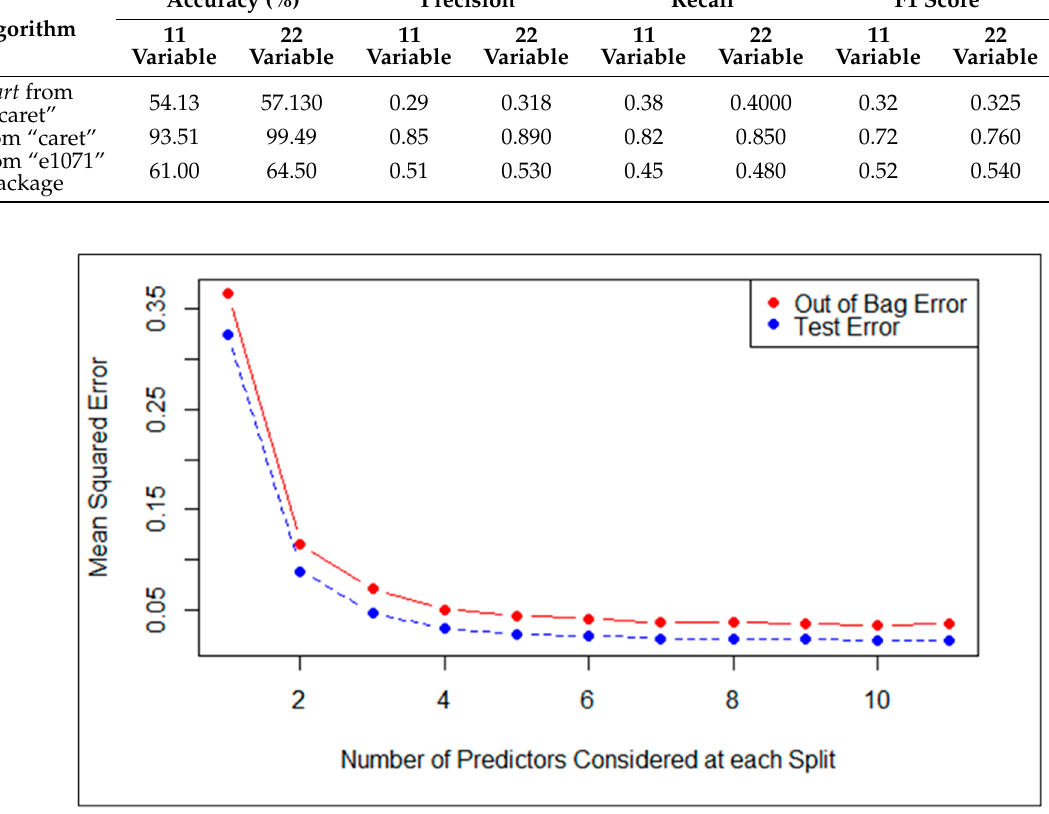
Figure 14. Test error and out-of-bag (OOB) error rate of the predicted model. The red line represents the out-of-bag error estimates, and the blue line represents the error calculated on test set. Both curves are relatively smooth, and the error estimates are also correlated. The error inclines are reduced at around mtry = 3. Hence, the final model with the 11 most important variables produced an accuracy of 93.51%, with ntree = 440 and mtry = 3. The model performance comparison among the random forest, decision tree and Naïve Bayes methods are shown in Table 6 for both models with 22 variables and 11 variables. Table 6. Model assessment for decision tree, random forest and Naïve Bayes.